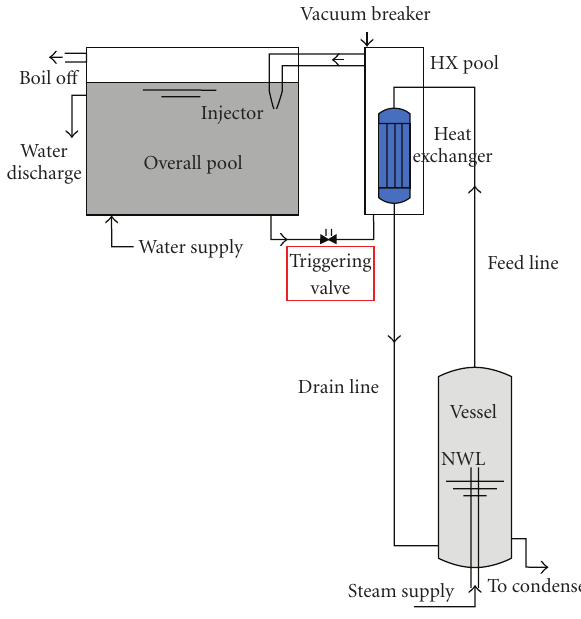
Figure 13: PERSEO facility scheme.